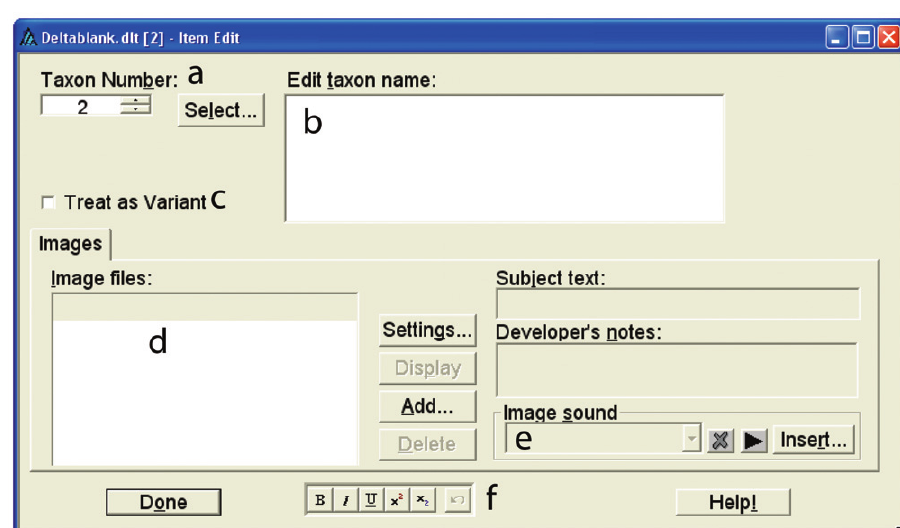
Figure 3a–f. Taxon editor, explanations in the